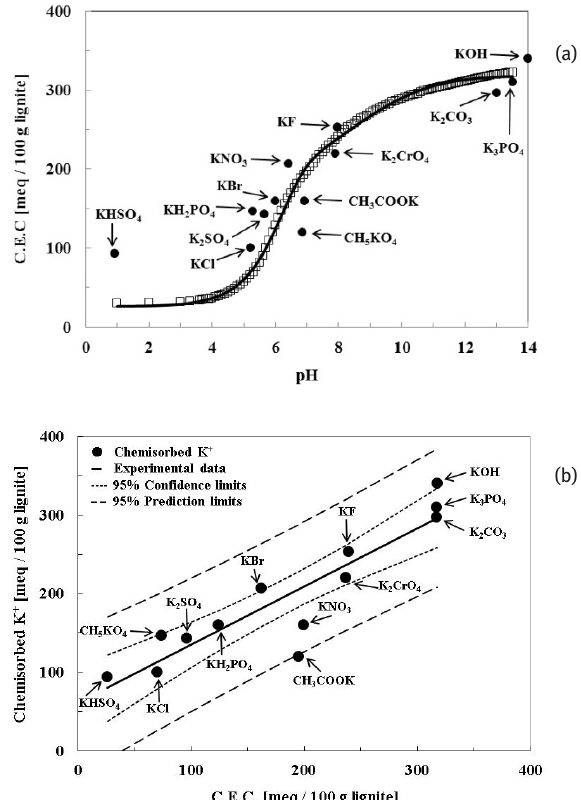
Figure 2: Effect of the solution pH on the CEC and on the amount of the chemisorbed potassium (a) experimental results (b) regression analysis